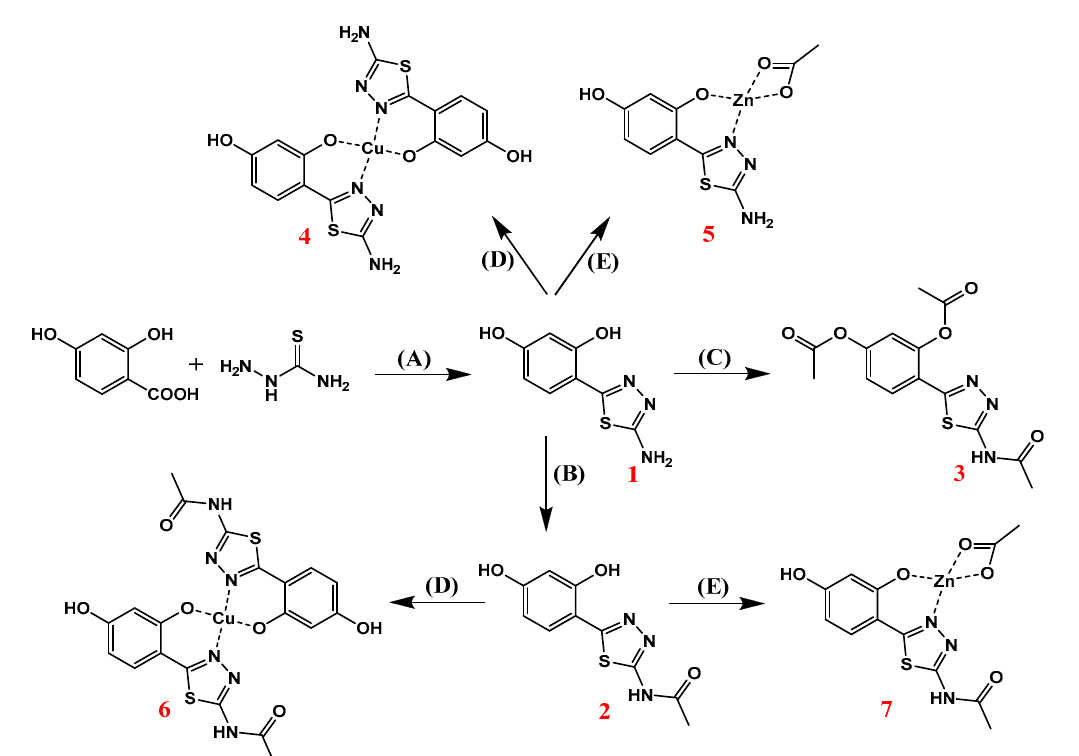
Figure 2. Synthetic pathway for the synthesis of 1,3,4-thiadiazole-derived ligands 1 – 3 , and their corresponding Cu(II) and Zn(II) complexes 4 – 7 : ( A ) POCl 3 , 75 °C; ( B ) Ac 2 O, H 2 O, reflux; ( C ) Ac 2 O, H 2 SO 4 , reflux; ( D ) Cu(CH 3 COO) 2 xH 2 O, MeOH / H 2 O, reflux; ( E ) Zn(CH 3 COO) 2 xH2O, MeOH / H 2 O, reflux. For better clarity, the hydrated water was omitted in the structures of